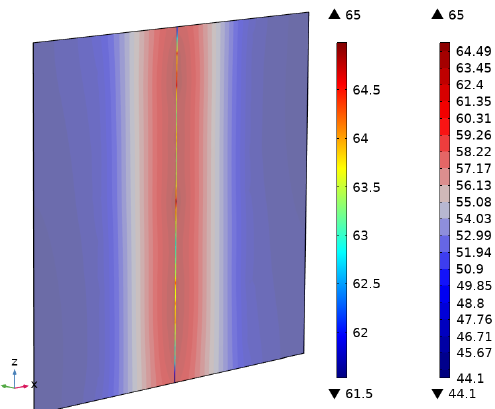
Figure 12. Temperature distribution inside the battery pack after 1500 s: ( a ) no thermal conductive layer; ( b ) by considering the GNP layer as heat spreader with the ambient.